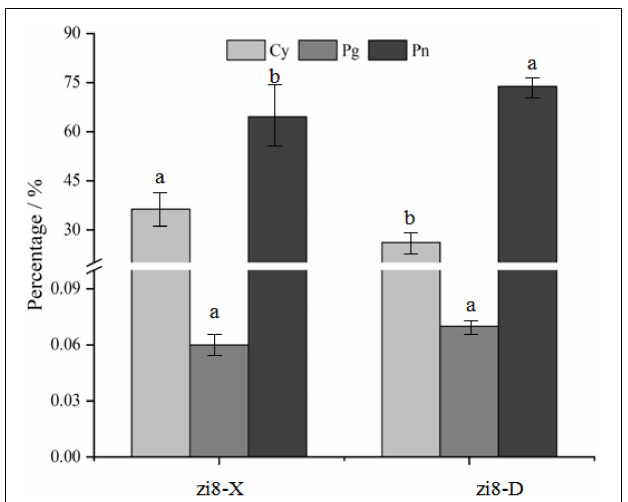
FIGURE 1 | Quantitative of anthocyanidins and their percentage in zi8-X and zi8-D.